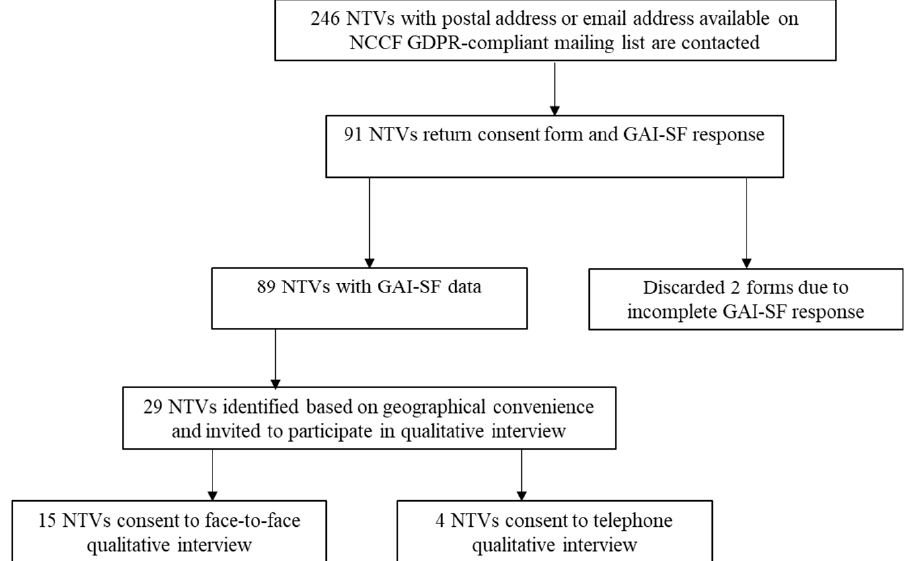
Figure 1. Flowchart for participant recruitment. NTVs = nuclear test veterans. NCCF = Nuclear Community Charity Fund. GDPR = General Data Protection Regulation. GAI-SF = Geriatric Anxiety Inventory – Short Form.